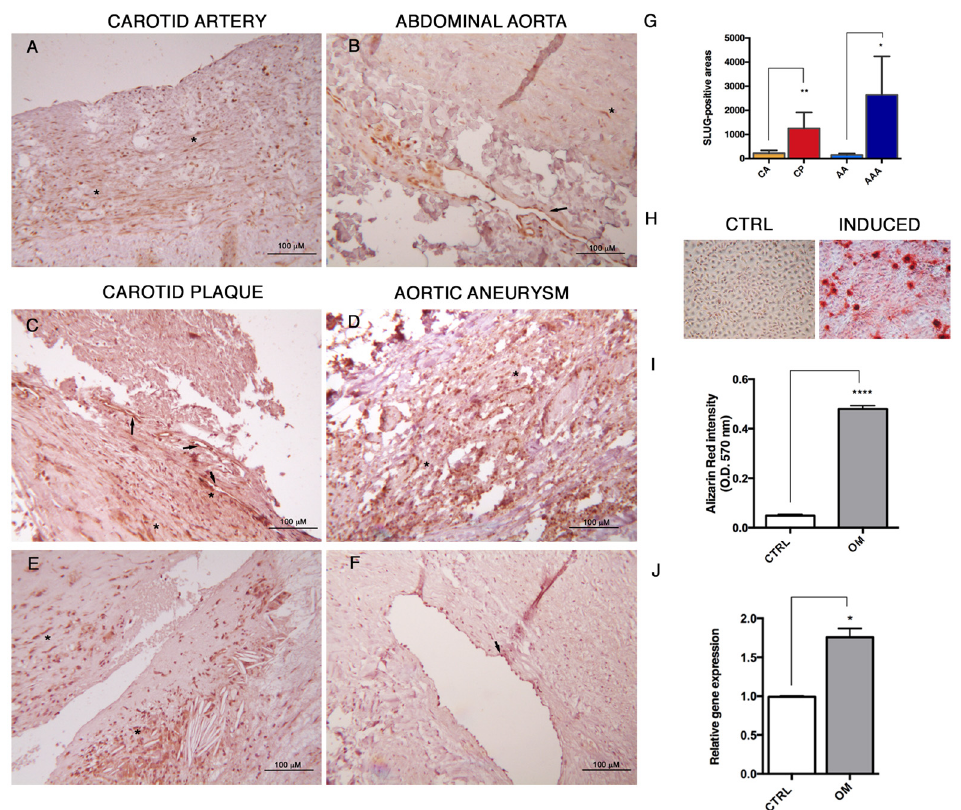
Figure 6. SLUG is involved in human atherosclerosis and endothelial osteogenic differentiation. ( A ) Immunohistochemistry was performed for detecting SLUG protein in human normal carotid artery, ( B ) abdominal aorta, ( C , E ) carotid plaque and ( D , F ) abdominal aortic aneurysm. Scale bars = 100 µ m. ( G ) Quantification of SLUG-positive stain was performed by Image Pro Plus software as the sum of positive areas and reported as mean ± SD. Abbreviations used in the graph: CA: carotid artery; CP: carotid plaque; AA: abdominal aorta; AAA: abdominal aortic aneurysm. ( H ) Mineralization assay performed on HUVECs after 14 days of exposure to osteogenic induction medium, and stained with Alizarin Red. ( I ) Quantification of calcium-bound Alizarin Red by absorbance measured at O.D. 570 nm by spectrophotometry. Data were normalized to control in DMEM 10% FBS. ( J ) Transcriptional levels of SLUG in HUVECs differentiated toward the osteogenic lineage after induction with specific medium for 14 days. Results are reported as fold changes relative to controls in DMEM 10% FBS. All data are expressed as mean ± SD of at least 3 independent experiments, and statistical analysis was performed by unpaired Student’s t test. *, p < 0.05; **, p < 0.001; ****, p < 0.0001.